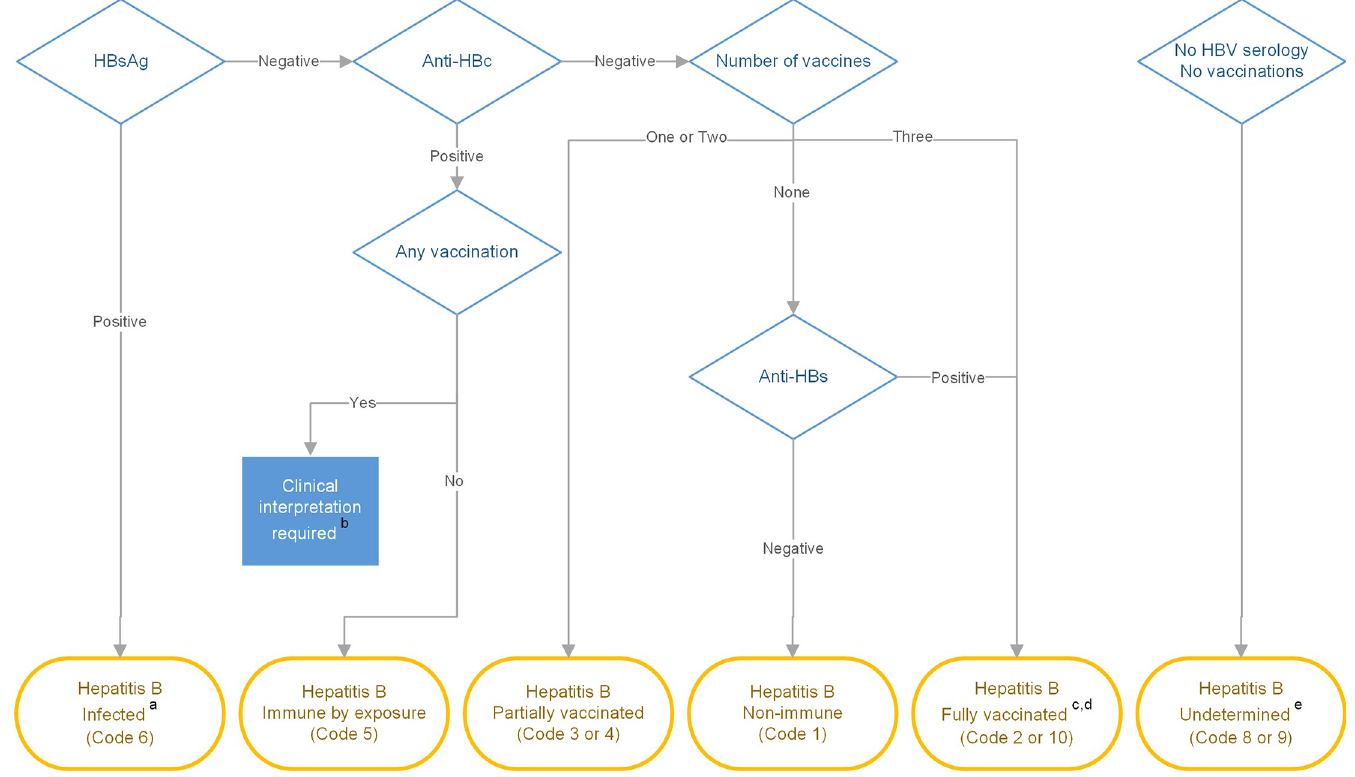
Fig 2. Algorithm used to allocate a code number to each individual. a If HBsAg positive apply regardless of other data. b Anti-HBc positive in the presence of any vaccines resulted in interrogation of clinical record to determine the temporal relationship between the HBV test and administration of vaccines. c All people born since 1990 with 3 documented vaccination, given at correct intervals, were coded as fully vaccinated, even if HBV tests were not available. d Isolated Anti-HBs positive in the absence of either Anti-HBc or any record of vaccination were allocated a HBV code of presumed fully vaccinated. e Recall added to record for HBV test, no HBV status added to primary care